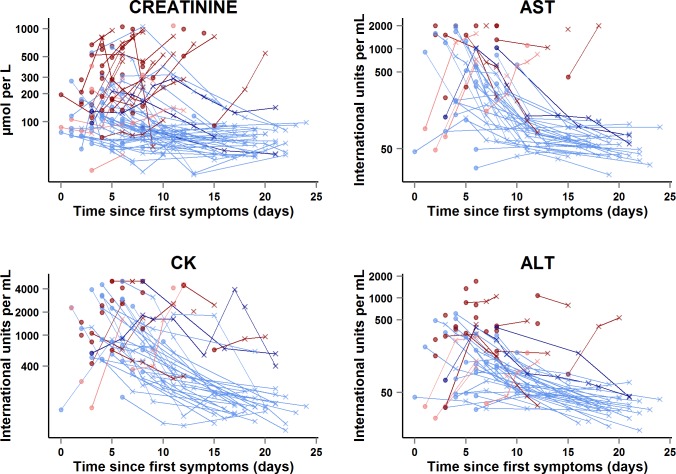
JIKI trial: evolution of serum creatinine, aspartate aminotransferase, alanine aminotransferase, and creatine phosphokinase in adolescents and adults.The x-axis represents the time since first symptoms (for example, for a patient whose first symptom occurred 5 d before day 0, the baseline value dot is positioned at 5 d). Each line represents one patient. Dots represent baseline values, and X’s represent follow-up values. Red symbols represent patients who died; blue symbols represent patients who survived. Dark red lines represent patients with baseline Ct < 20 who died, light red lines represent patients with baseline Ct ≥ 20 who died, dark blue lines represent patients with baseline Ct < 20 who survived, and light blue lines represent patients with baseline Ct ≥ 20 who survived. Samples obtained more than 25 d after onset of symptoms are not represented.